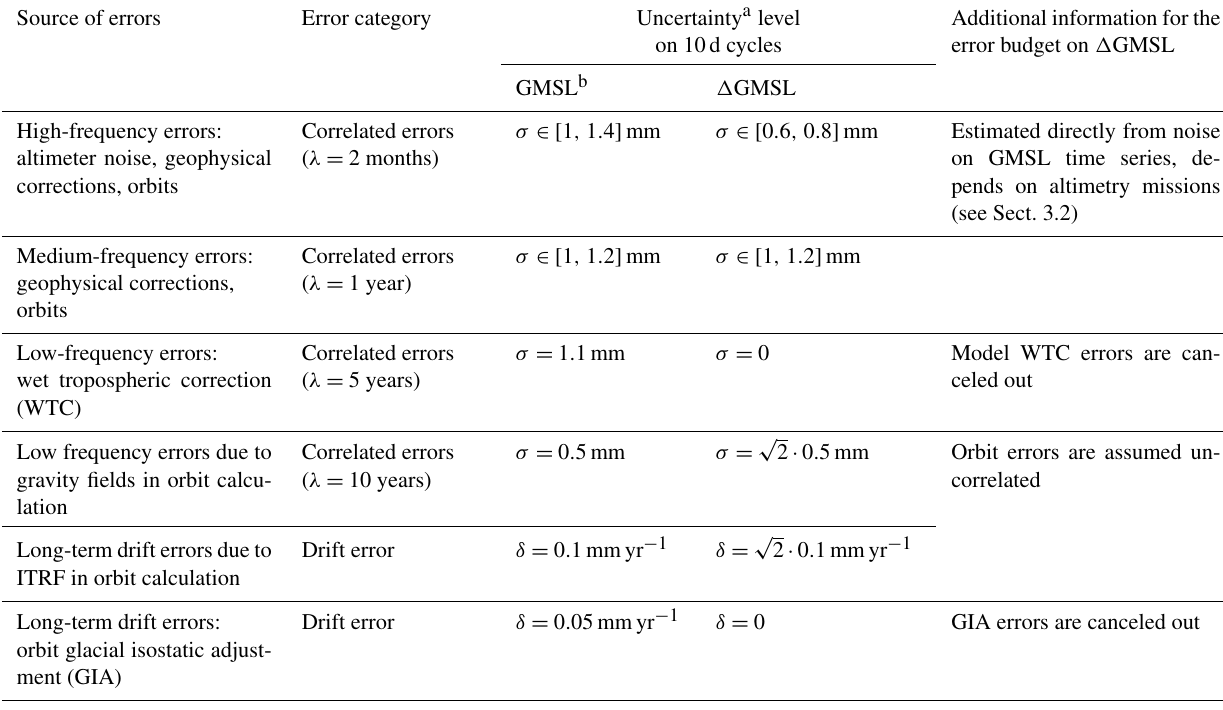
Table 1. Error budget of (cid:49) GMSL between two altimeter missions ( (cid:49) GMSL) derived from the GMSL error budget from Ablain et al. (2019). Source of errors Error